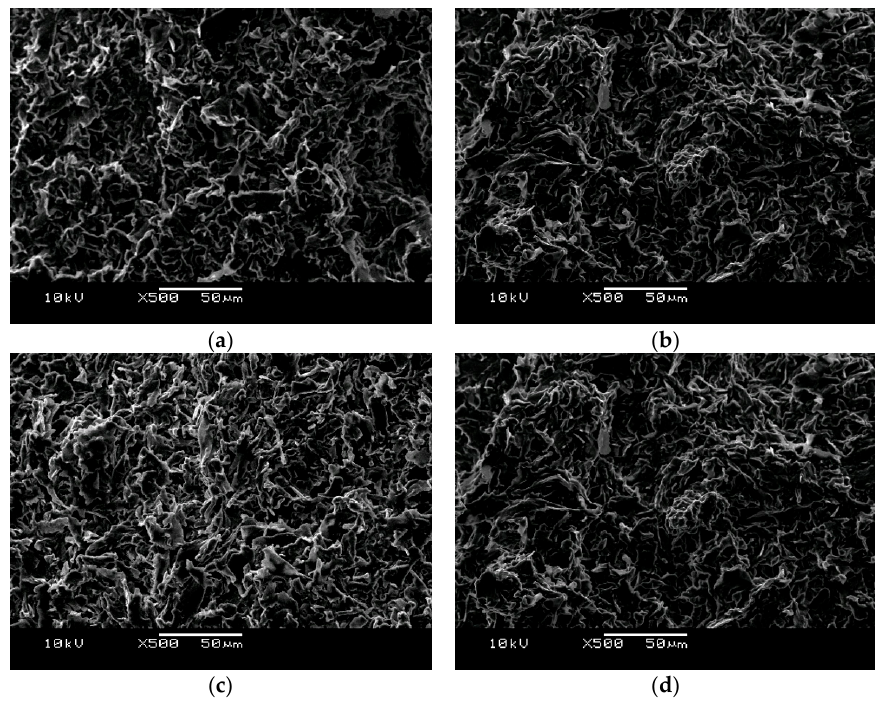
Figure 1. SEM images of ( a ) 70 wt % coconut oil + 30 wt % n ‐ hexadecane Mixed shape ‐ stabilized phase change materials (SSPCM), ( b ) 50 wt % coconut oil + 50 wt % n ‐ hexadecane Mixed SSPCM, ( c ) 30